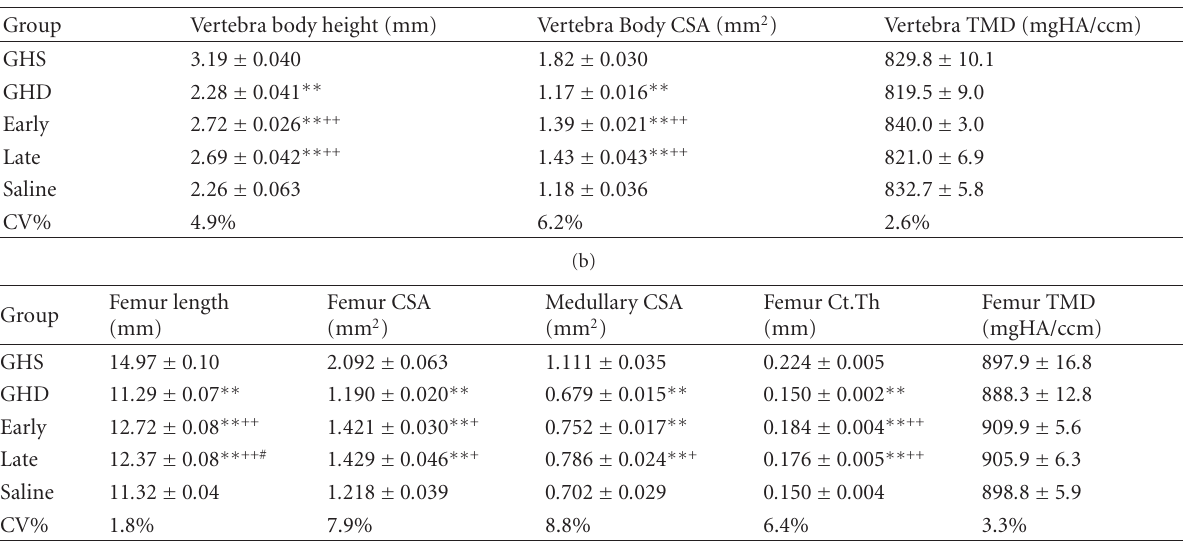
Table 1: Vertebral and femoral tissue mineral density (TMD) and bone macrostructure including cross-sectional area (CSA) and cortical thickness (Ct.Th) in GH-su ffi cient (GHS), GH-deficient (GHD), early treatment (early; daily GH injections from age 21 to 60 days), late treatment (late; daily GH injections from age 35 to 60 days), and saline control (saline; daily saline injections from age 21 to 60 days). Mean and standard errors are reported, and the coe ffi cient of variation (CV%). ∗ P ≤ 0 . 05, ∗∗ P ≤ 0 . 001 versus GHS, + P ≤ 0 . 05, ++ P ≤ 0 . 001 versus GHD, # P ≤ 0 . 05 versus early.